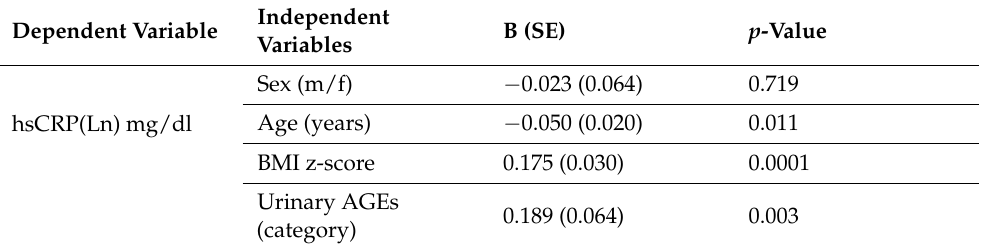
Table 3. Linear regression analysis model with hsCRP concentration as a dependent